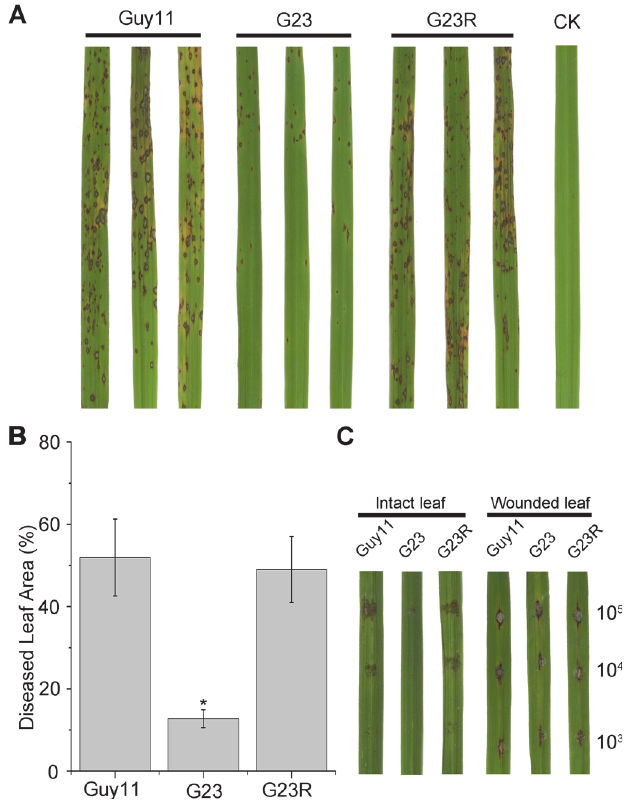
Fig 5. Pathogenicity assays on rice leaves. (A) Spray inoculation with 4-week-old rice seedlings. Rice leaves ( O . sativa cv. CO-39) were inoculated with conidia at a concentration of 5×10 4 conidia ml − 1 . Representative leaves were photographed 6 days post-inoculation. The experiments were repeated at least three times with triple replications that yielded similar results. (B) Disease severity of each strain was assessed from the percentage of diseased leaf area as described by Fang and Dean (2000). ANOVA analysis was performed after percentages were arcsine transformed. However, the original percentages were used for presentations. Error bars represent SD of the original percentages. Asterisks in each data column indicate significant differences at p = 0.05. (C) Drop inoculation with 20 μ l serial dilutions of conidia suspension on intact and wounded rice leaf segments. Representative leaves were photographed 6 days